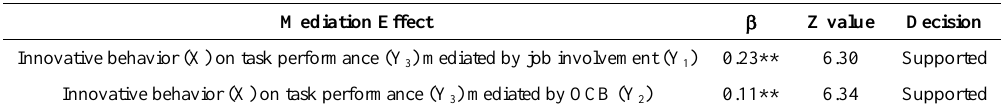
Table 4. Mediation effect